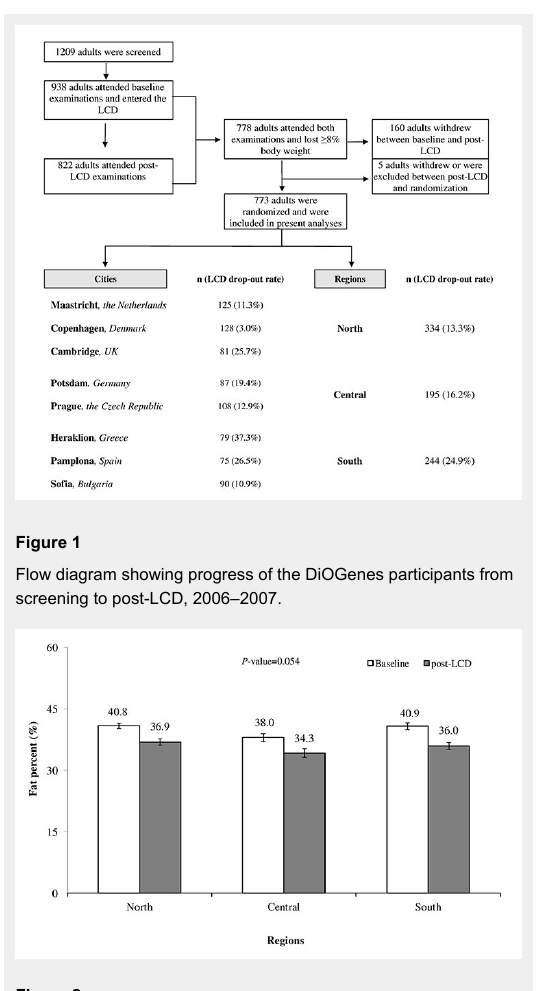
Figure 2 Body fat percentage over the LCD period in the DiOGenes participating regions, 2006–2007. LCD = low-calorie diet; bars (I) indicate 95% confidence intervals; comparisons in body fat percentage changes between regions were performed using analysis of covariance, with age, gender, baseline body fat percentage and LCD duration (weeks) as